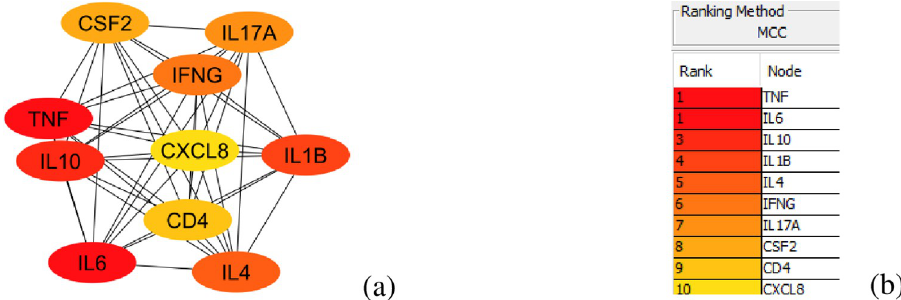
Fig 3. The final results are shown in cytoHubba. (a) PPI Network of the top 10 hub genes. The red color indicates the nodes with high MCC scores, and the yellow indicates the node with a low MCC score. (b) Ranking of the top 10 hub genes using the MCC algorithm.